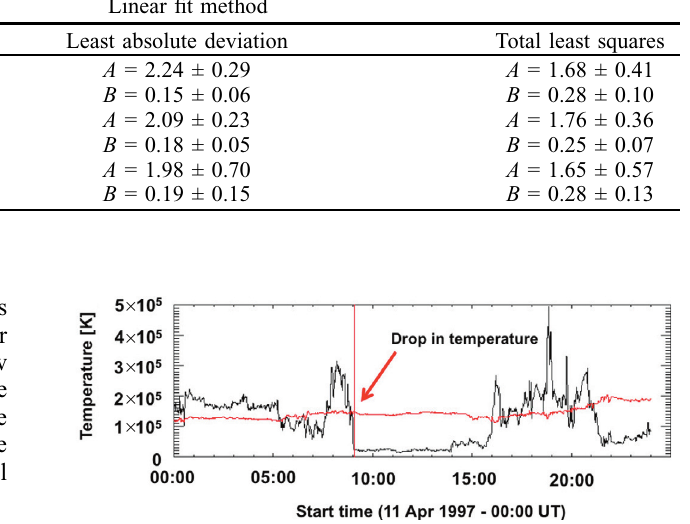
Fig. 4. Temperature profiles around and during the passage of an ICME at the Wind spacecraft. The black curve is the measured proton temperature. The red profile is the expected temperature (Eq. 2) for the observed solar wind speed as a function of time. The red arrow marks the ICME arrival